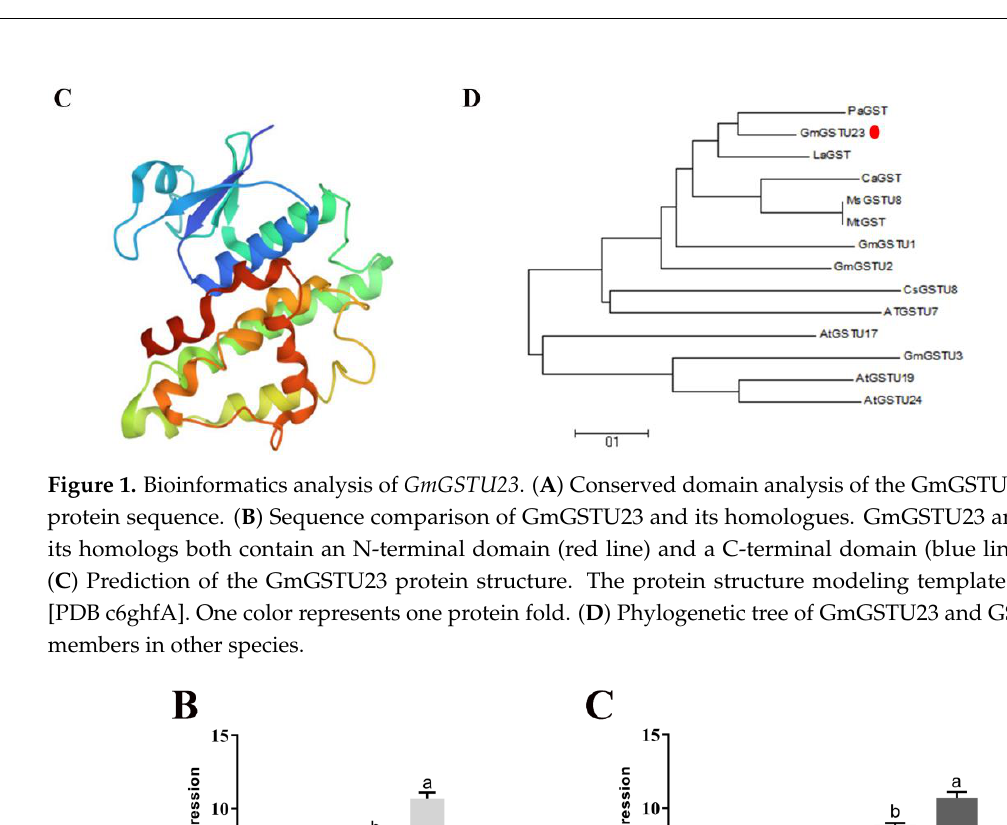
Figure 3. Overexpression of GmGSTU23 relieved the inhibition of root elongation by salt stress. ( A ) Phenotypes of the GmGSTU23 transgenic lines in plate culture. ( B ) Analysis of root elongation of seedlings. Scale bar = 1 cm . The bars represent the average ± SD of three replicates. Different letters above the bars indicate significant differences among the treatments ( p < 0.05). WT, wild type; OE- 2, OE-5, OE-11: GmGSTU23 transgenic lines.